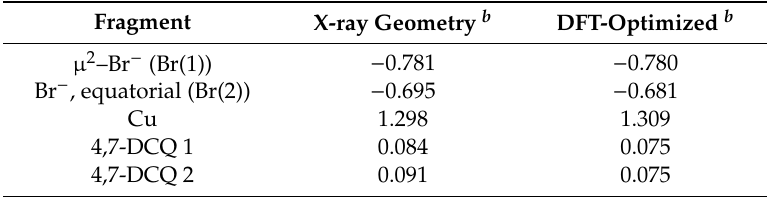
Table 3. Mulliken net atomic charges (electrons) of relevant symmetry-independent chemical moieties in CDCQB, as obtained from M06/TZVP calculations on isolated complexes. a.